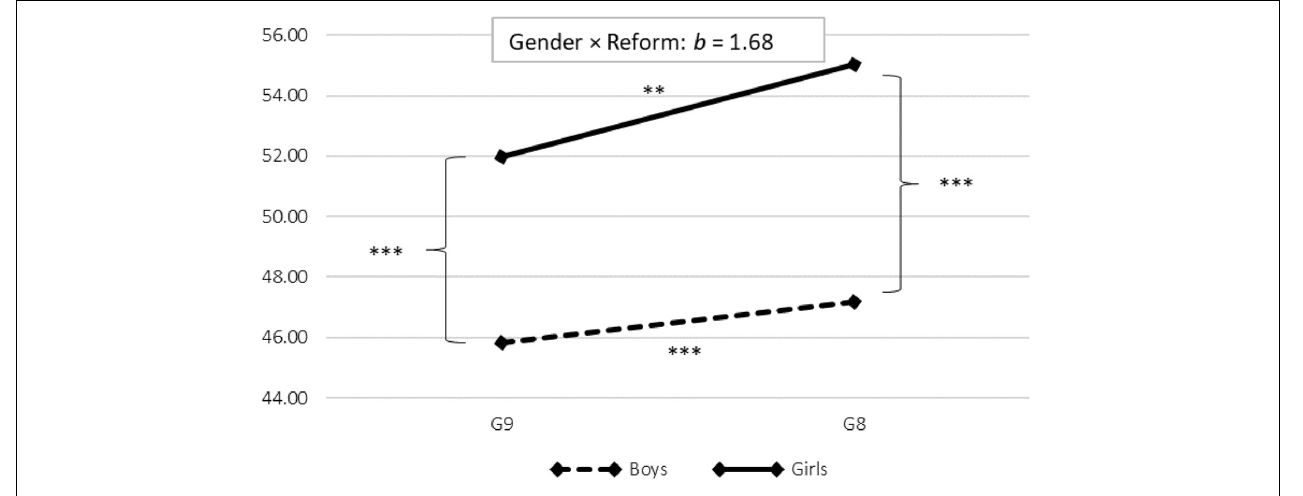
FIGURE 2 | Gender-specific interaction effect for achievement-related fear. Based on findings reported in Table 3 . ∗∗∗ p < 0.001. ∗∗ p <